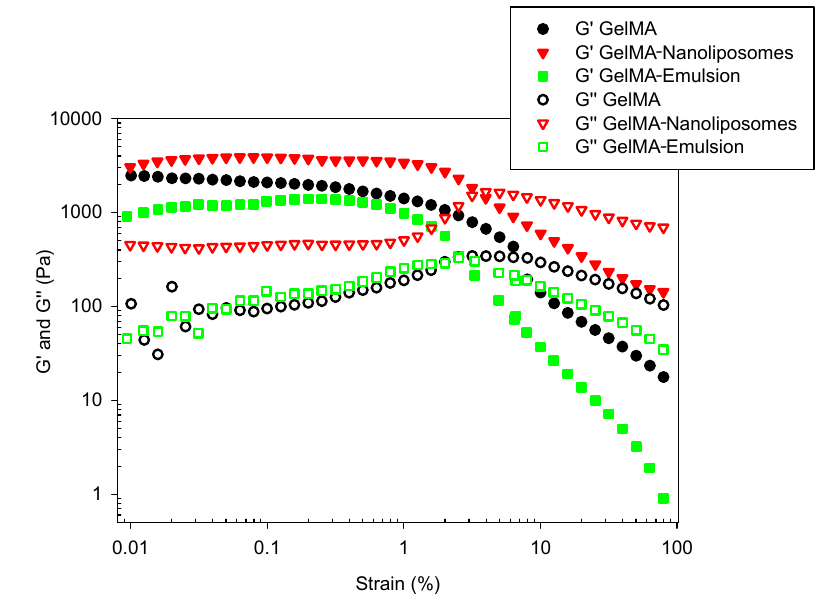
Figure 7. Amplitude sweeps showing storage moduli (G ′ ) and loss moduli (G ″ ) of the hydrogels performed over the whole strain range at a frequency of 1 Hz.